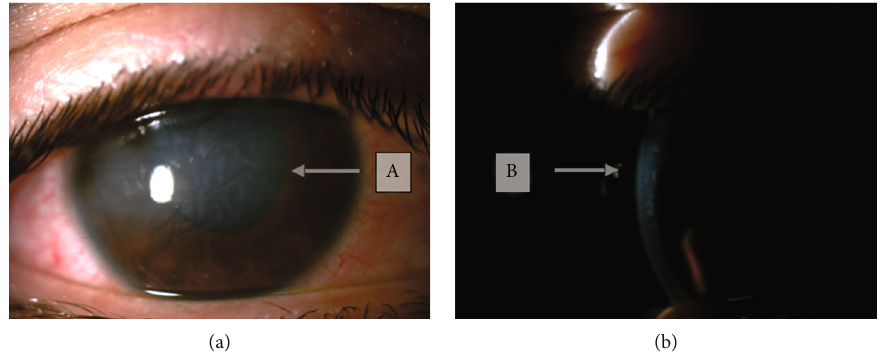
Figure 2: Corneal edema in the right eye during TASS, as seeing both with di ff use (a) and laminar (b) lighting.